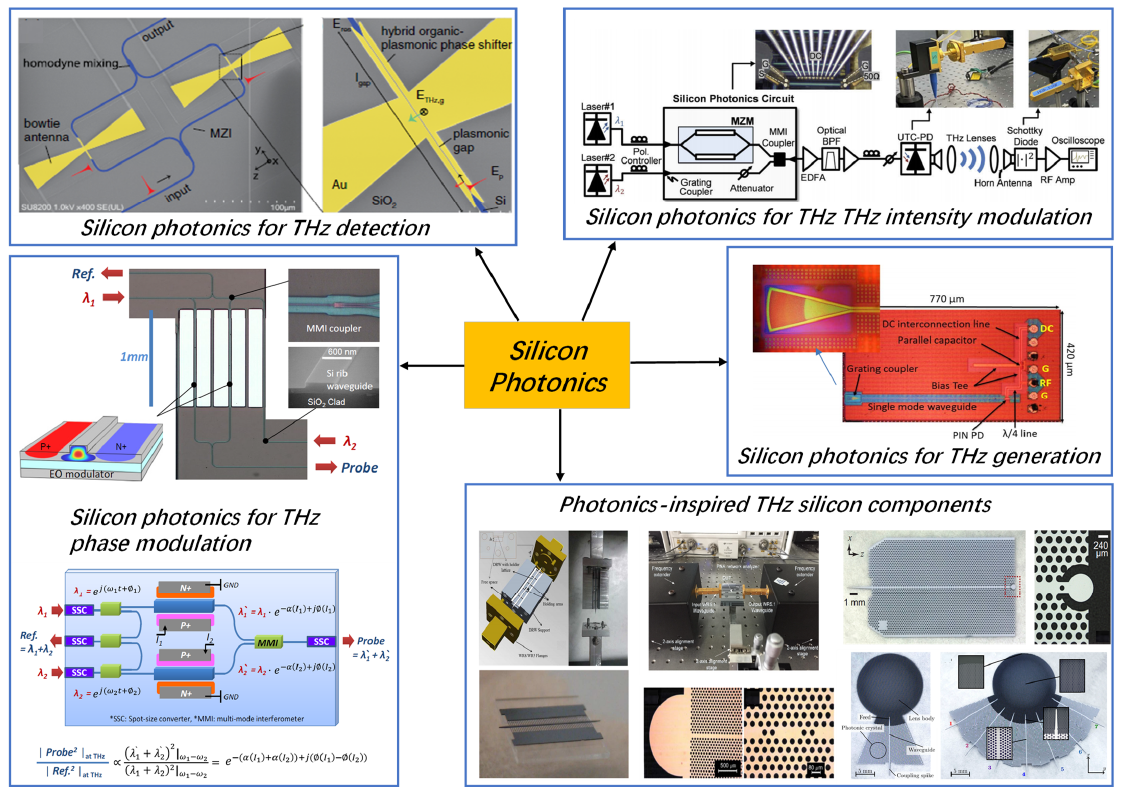
Figure 3. Applying silicon photonics in the THz techniques. © 2018 IEEE. Reprinted, with permission, from [55]. Reprinted with permission from [56]. © The Optical Society, 2020. Reprinted with permission from [57]. © The Optical Society, 2014. Reprinted with permission from [58]. © The Optical Society, 2020. Reprinted with permission from [59]. © The Optical Society, 2017. Reproduced from [60], with the permission of AIP Publishing, 2018. Reproduced from [61], with the permission of AIP Publishing, 2009. © 2014 IEEE. Reprinted, with permission, from [62]. © 2015 IEEE. Reprinted, with permission, from [63]. Reprinted with permission from [64]. © The Optical Society, 2018.